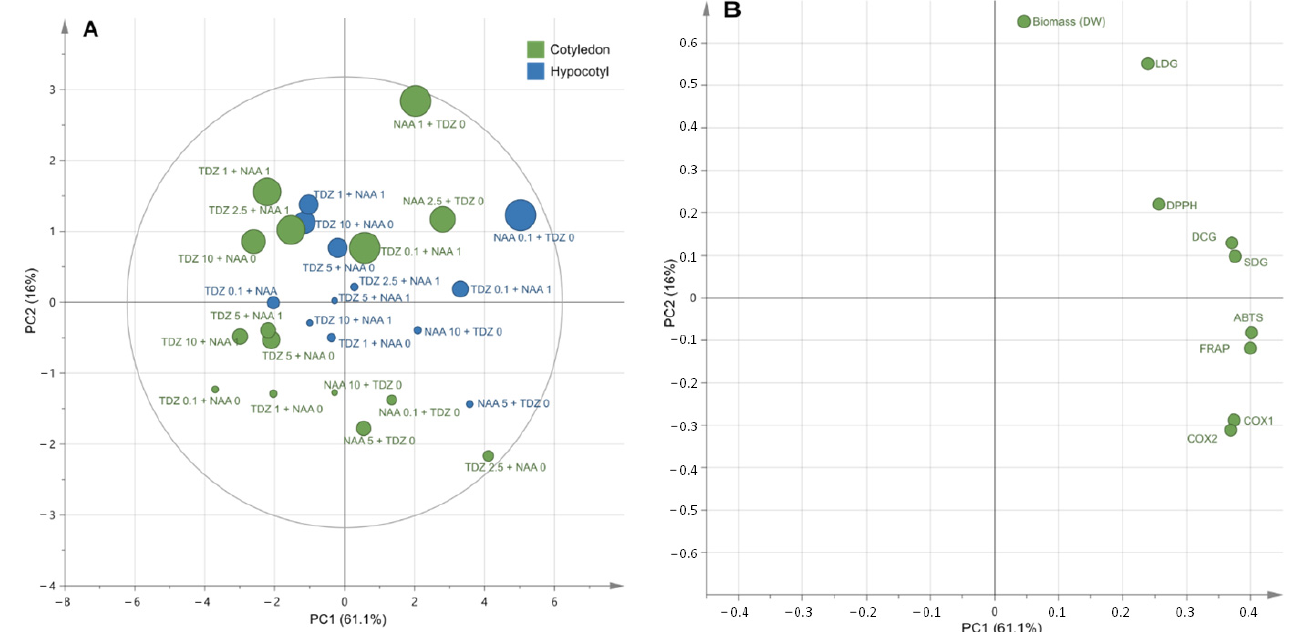
Figure 4. Principal component analysis (PCA) for the discrimination of the different L. grandiflorum extracts derived from callus cultures as a function of their phytochemical compositions and biological activities, with circle size relative to biomass, expressed as dry weight. Score plot ( A ); loading plot ( B ). Explained variance by factor 1 (PC1) = 61.1% and by factor 2 (PC2) = 16%.